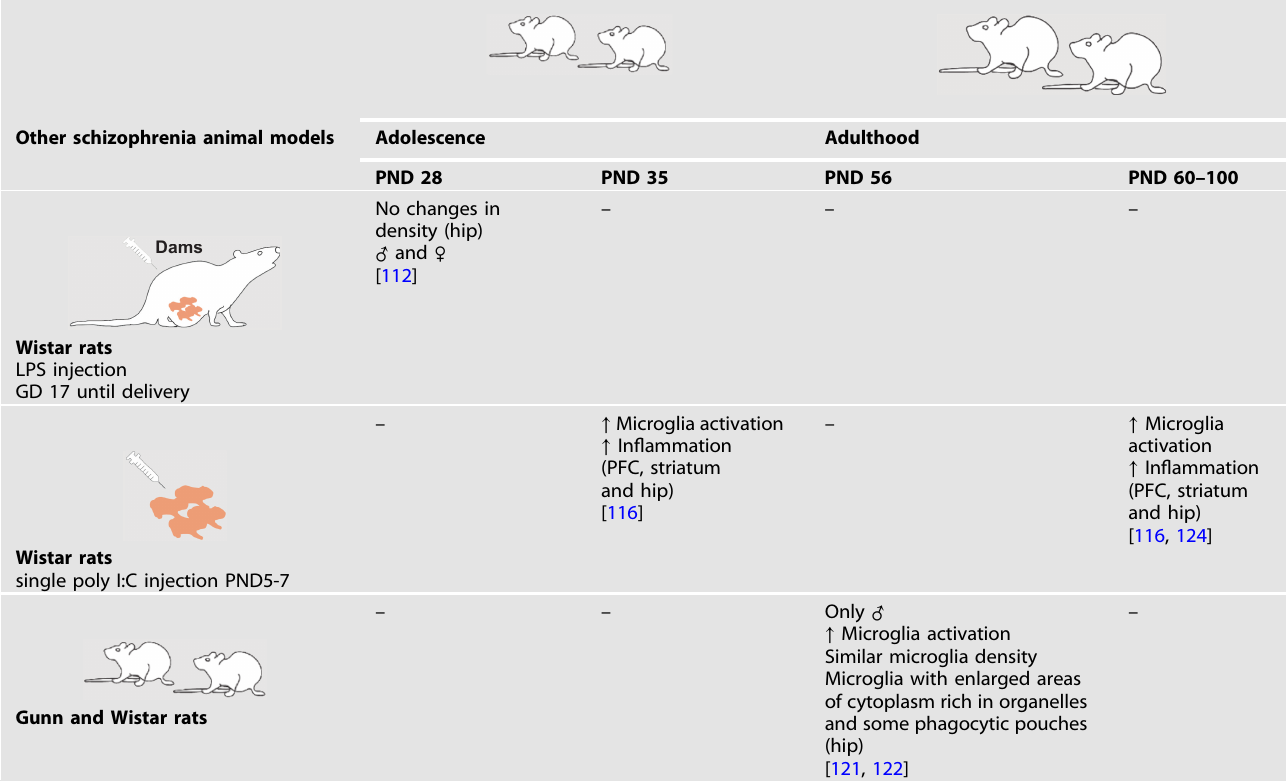
Other schizophrenia animal